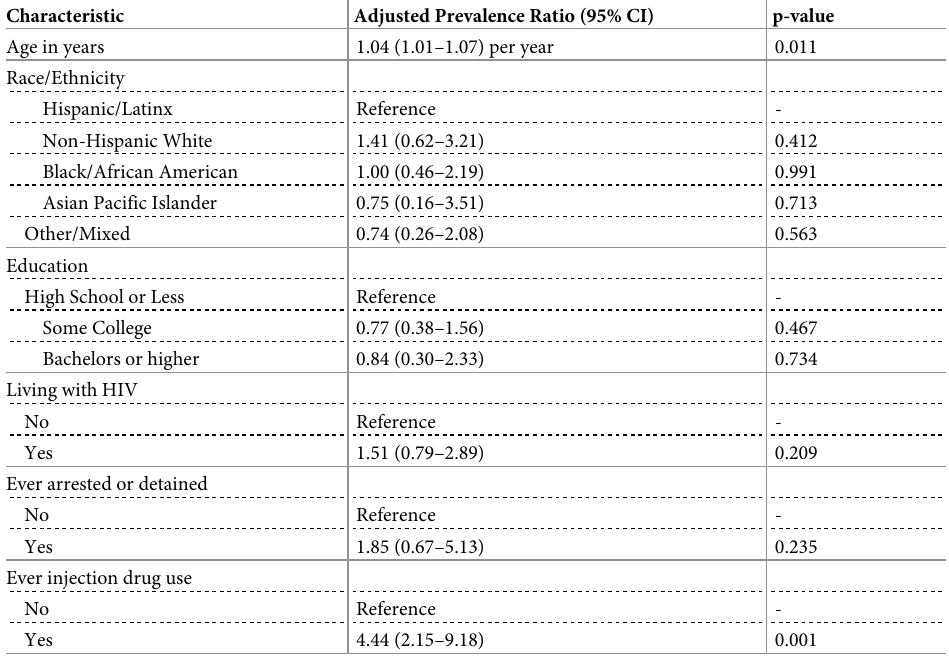
of those 12 individuals used injection drugs in their lifetime and nine (75%) injected in the last twelve months. Eleven (92%) reported being arrested or detained by police at some point in their lifetime. Seven (58%) were currently experiencing homelessness and 11 (92%) experi- enced homelessness in the past 12 months Seven (58%) of those who were living with HCV viremia were living with HIV. Four (33%) required healthcare in the past 12 months but were unable to afford it. Among the 12 participants with HCV viremia, 11 (92%) were HCV seropositive (Table 4). The participant who was not seropositive had been screened for HCV in the past but not diag- nosed with HCV previously, thus we may have observed an acute HCV infection. Three quar- ters (75%) had been diagnosed with HCV in the past but only 1 (12%) reported receiving HCV treatment, which was not completed. Two (17%) reported having cleared their first infection Table 2. Independent associations with hepatitis C seropositivity among trans women in the National HIV Behav- ioral Surveillance (NHBS) survey, San Francisco, CA, 2019 (N =